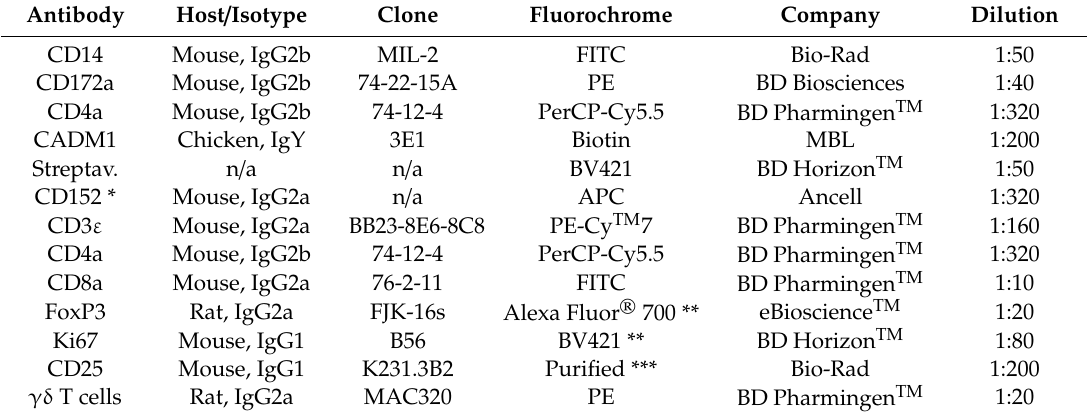
Table 1. Antibodies used to identify DC subsets, NK cells and T cell subsets in PBMCs and mesenteric lymph node (MLN)